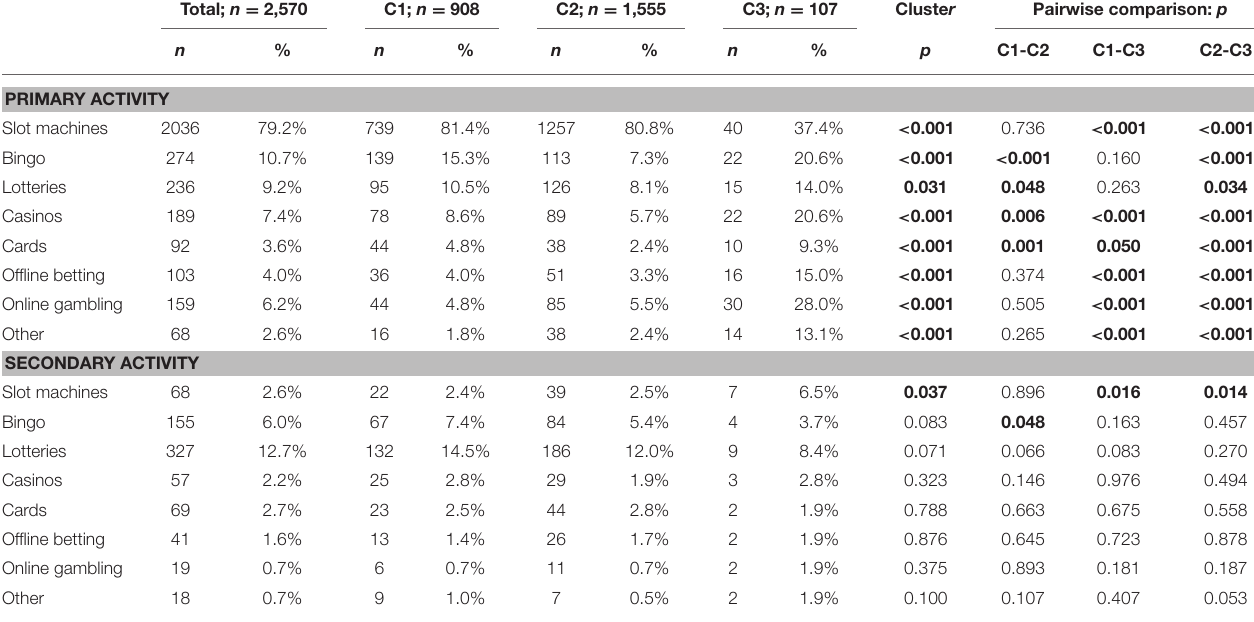
TABLE 2 | Comparison between clusters based on main gambling